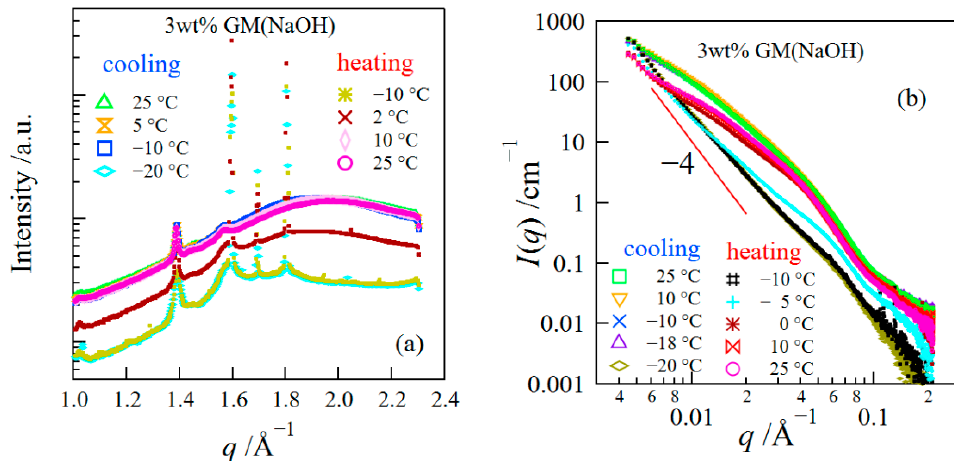
Figure 4. Representative compression stress–strain curves ( a ), the compressive stress at different strains ( b ), and SEM images of the cross-section of GM gels with and without FT treatment ( c ).